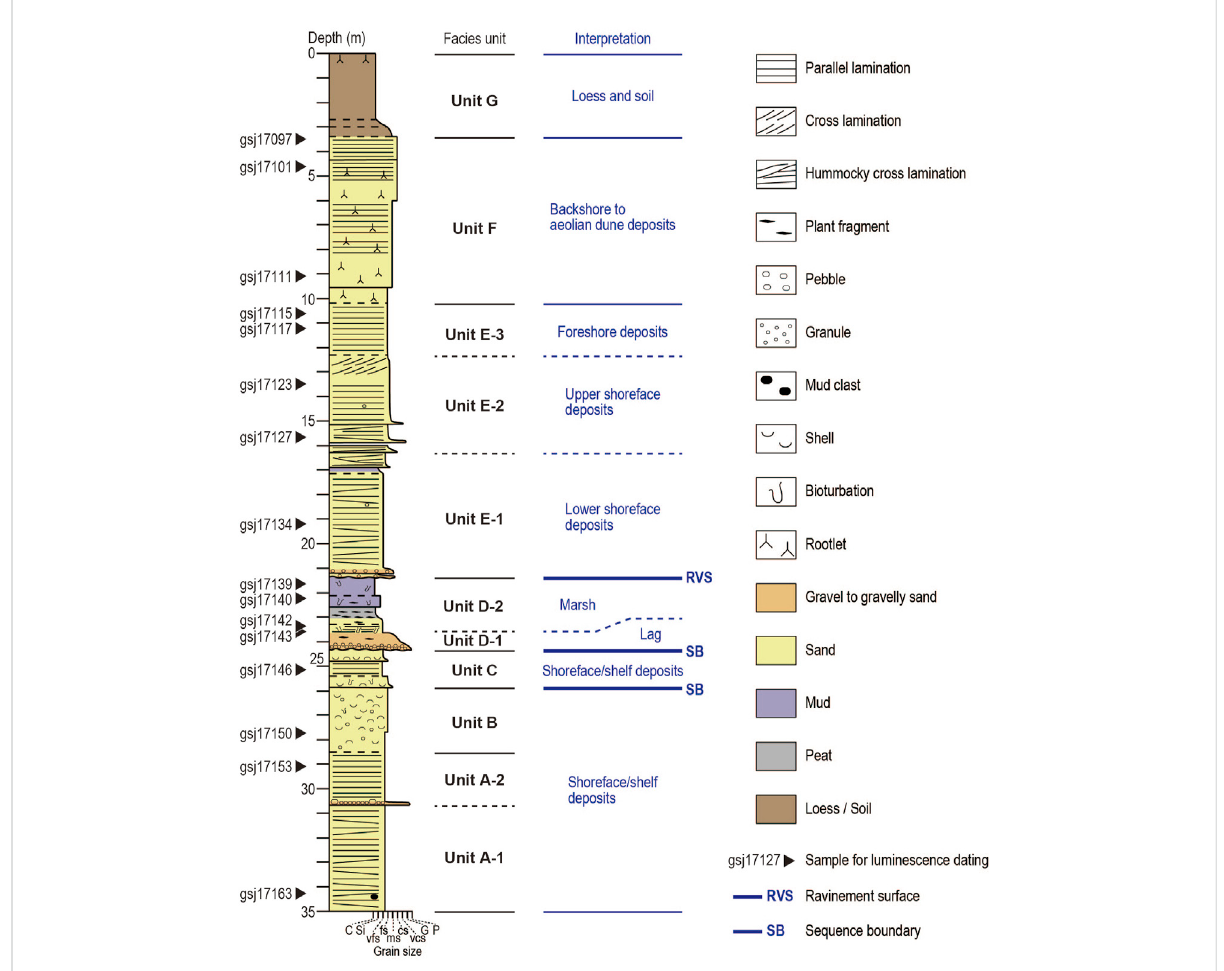
FIGURE 3 Columnar sections of core GS-HKT-1 with de fi nition and interpretation of units A to G, in ascending order and bounding surfaces. Sixteen sediment samples were collected for luminescence dating.